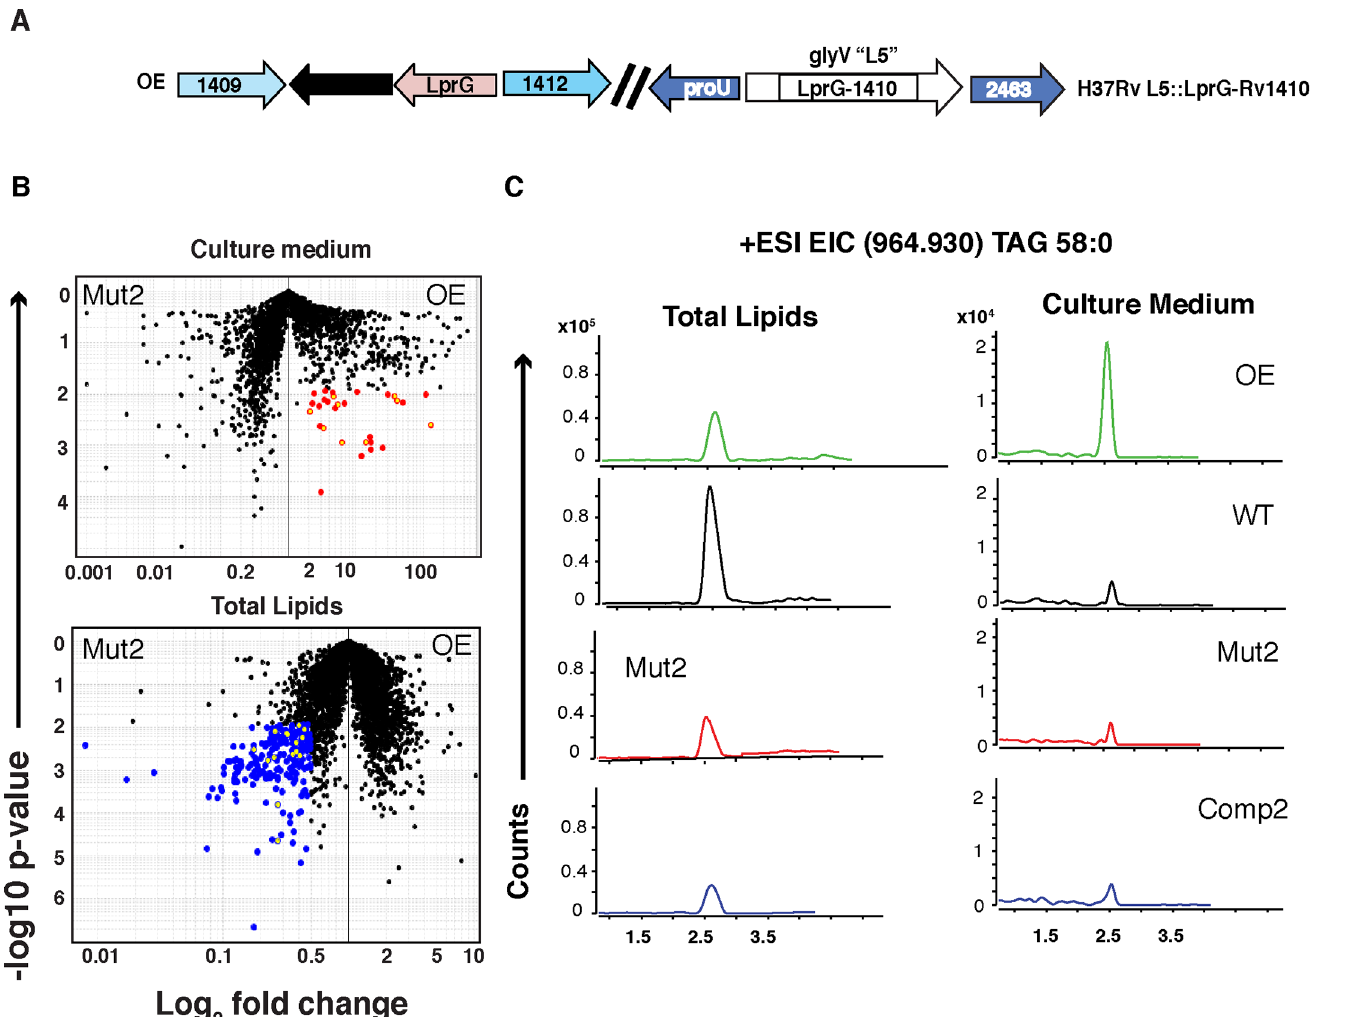
Fig 3. Overexpression of lprG-rv1410c increases TAG released into culture medium of broth-cultured cells. (A) Schematic of the overexpression (OE) genotype. (B) Comparative lipidomes of culture medium (upper) and total cells (lower) derived from the OE vs. Mut2 strains from log-phase broth-grown cells (OD 0.7 +/- 0.2). Upper panel, OE vs. Mut2 culture medium (12.5 μ g lipid); 2-fold increase, corrected p < 0.05 (red), TAG (yellow overlay). Lower panel, OE vs. Mut2 total cells (12.5 μ g lipid); 2-fold decrease, corrected p < 0.05 (blue), TAG (yellow overlay). Student ’ s paired t-test (Gene Pattern, Broad Institute of Harvard, MIT, MGH). (C) Extracted ion chromatogram (EIC) for m/z 964.963 (TAG 58:0) in culture medium versus total cell lipid from OE, WT, Mut2, and Comp2 strains within the same MS